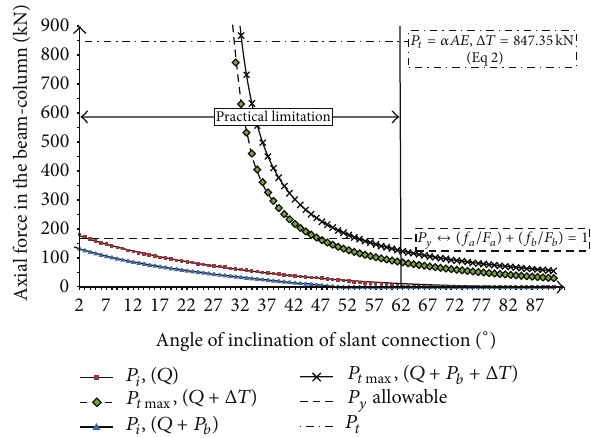
Figure 18: Relation between axial force in the beam with slope of slant connection ( 𝜃 ∘ ) due to nonsymmetric gravity load and elevated temperature (friction factor, 𝜇 𝑠 = tan 𝜑 = 0.3 ) (Δ𝑇) = 50 ∘